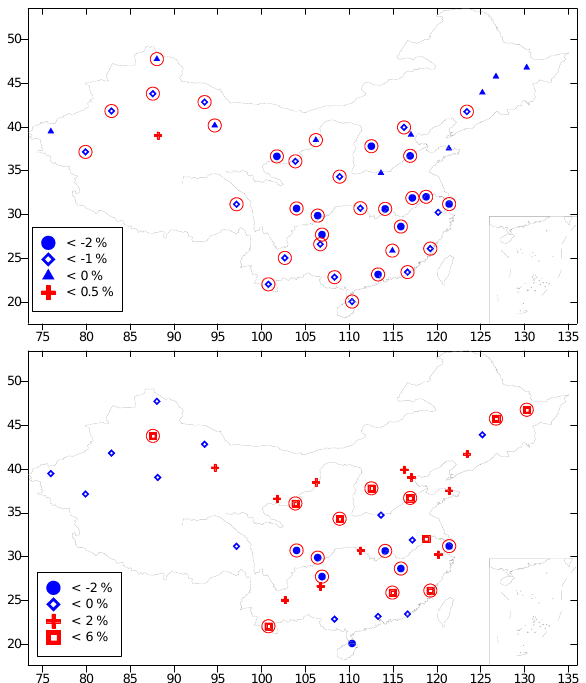
Fig. 6. The same as Fig. 1, but for the ratio of surface global radi- ation to solar radiation at the top of the atmosphere under clear-sky Figure 6. The same as Figure 1, but for the ratio of surface global radiation to solar conditions (up) and under cloudy-sky conditions (bottom). A clear radiation at the top of atmosphere under clear-sky condition (up) and under cloud-sky sky and a cloud sky are defined when the accumulation frequency condition (bottom). The clear-sky and cloud-sky is defined when the accumulation of the ratio is greater than 70% and less than 30%, frequency of the ratio is greater than 70% and less than 30%, respectively.